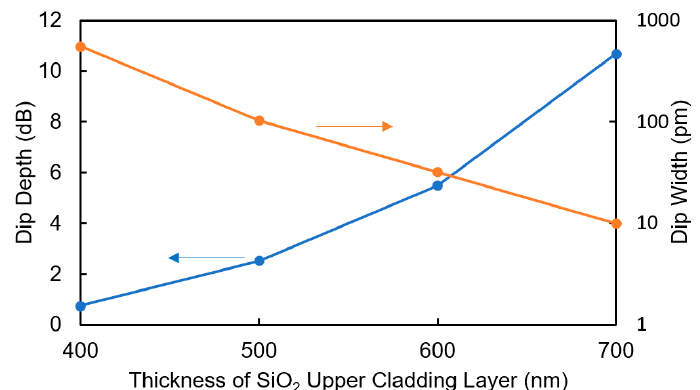
Figure 2. Calculated dip depth and width at 0.1 dB from the bottom of the dip for the MRR with L MRR = 69.3 µ m and K = 0.2 as a function of the thickness of the upper SiO 2 layer.